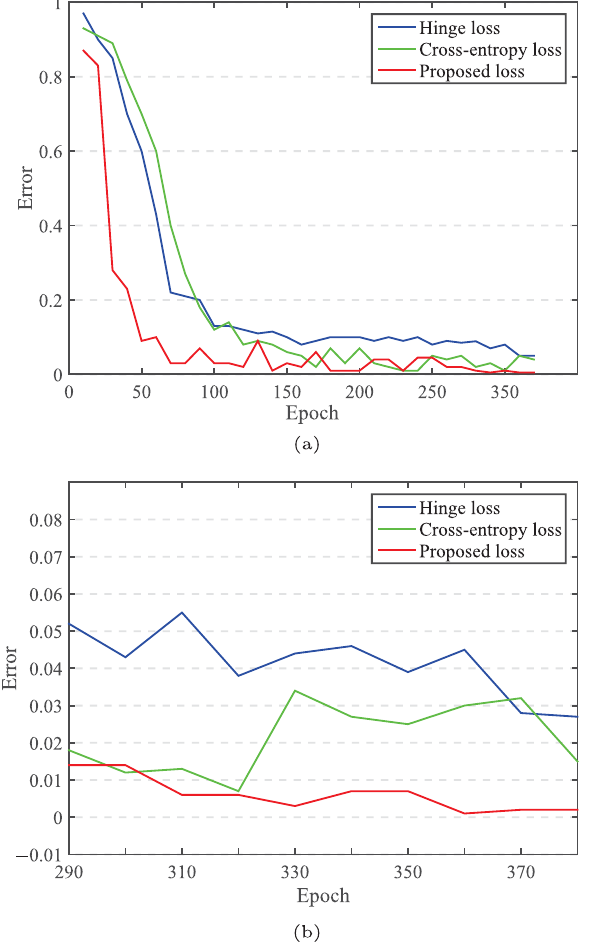
Fig. 4 Smoothed test error on MNIST for cross-entropy loss, hinge loss, and proposed loss: (a) epochs 0–400, (b) epochs 300–400.